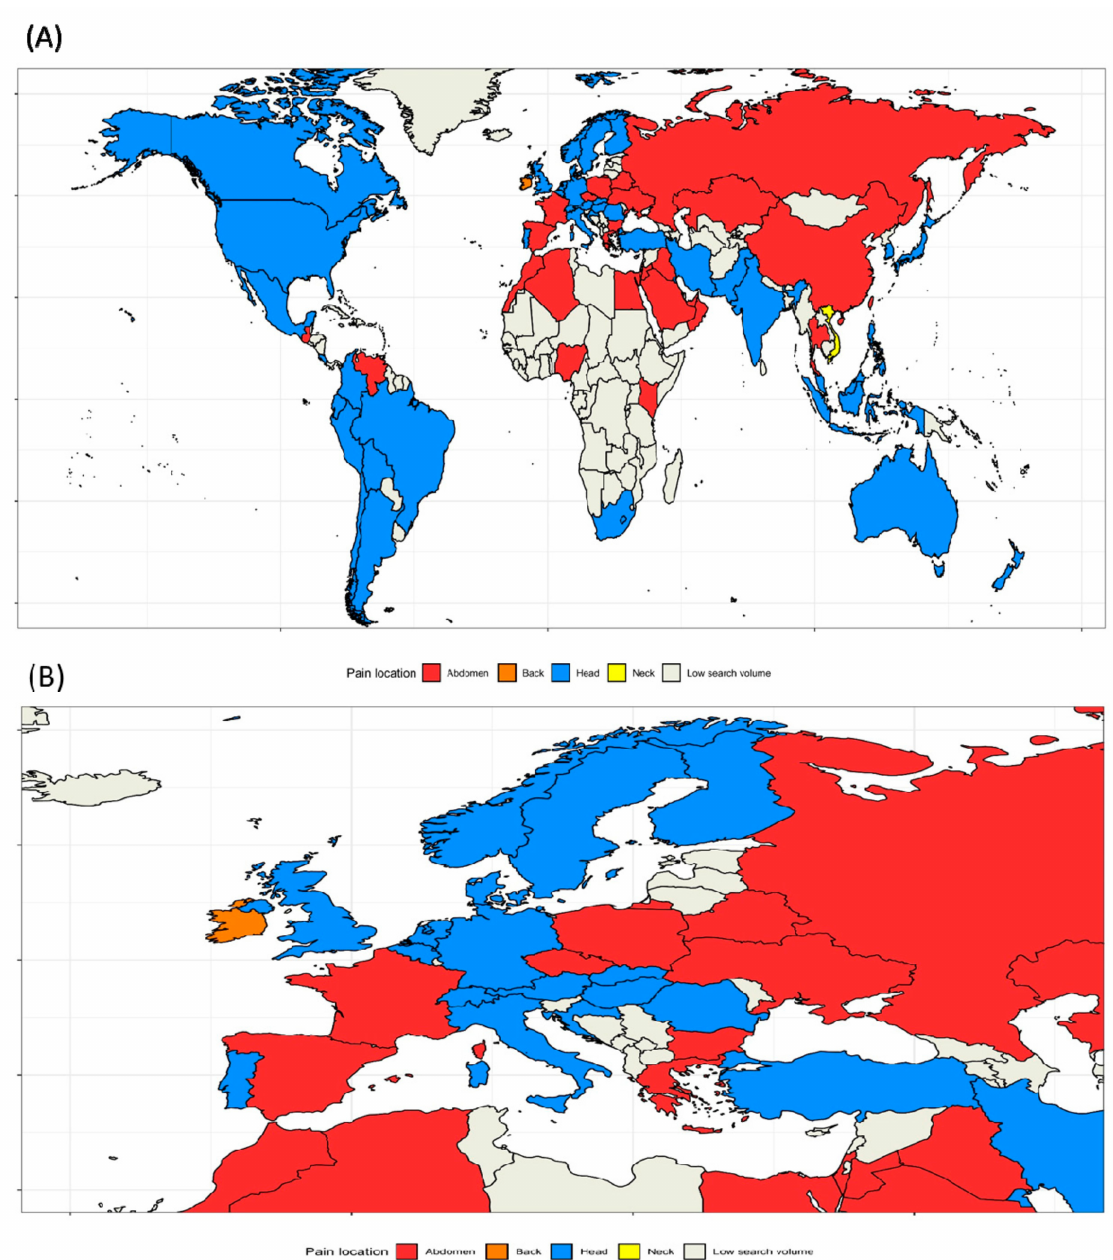
Figure 2. ( A ) World map showing the countries with the highest interest in the pain-related topics ( B ) Europe map showing the countries with the highest interest in pain-related